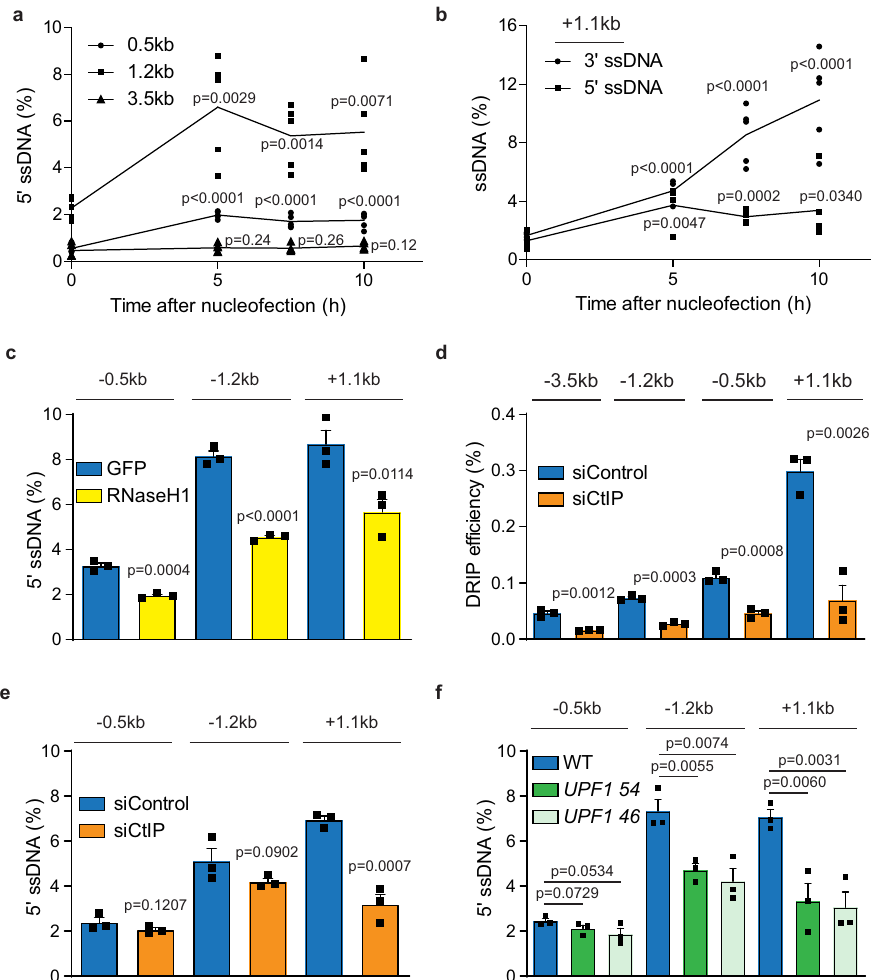
Fig. 6 UPF1 stimulates R loop formation at sub-telomeric DSBs. a – c QAOS analysis showing the level of 3 ′ and 5 ′ ssDNA at the indicated loci in RPE1 WT cells at the indicated time after TALEN nucleofection ( a , b ) or RPE1 cells expressing RNaseH1 or GFP at 10 h after nucleofection ( c ). Data plotted are mean + SEM, n = 5 for a , n = 5 for b (except for 5 h, n = 4), n = 3 for c . p values were obtained as described in Fig. 3a. d DRIP analysis showing the levels of DNA – RNA hybrids at the indicted loci in RPE1 cells transfected with CtIP or control siRNAs at 10 h after nucleofection. Data plotted are mean + SEM ( n = 3). p values were obtained as described in Fig. 5c. e , f QAOS analysis in RPE1 cells transfected with CtIP or control siRNAs ( e ) and RPE1 WT and UPF1 KO cells ( f ) at 10 h after nucleofection. Data plotted are mean + SEM ( n = 3). p values were obtained as described in Fig. 3a. The n values indicate the number of independent experiments in all (5 ′ ssDNA) at sub-telomeric DSBs. Depletion of CtIP strongly